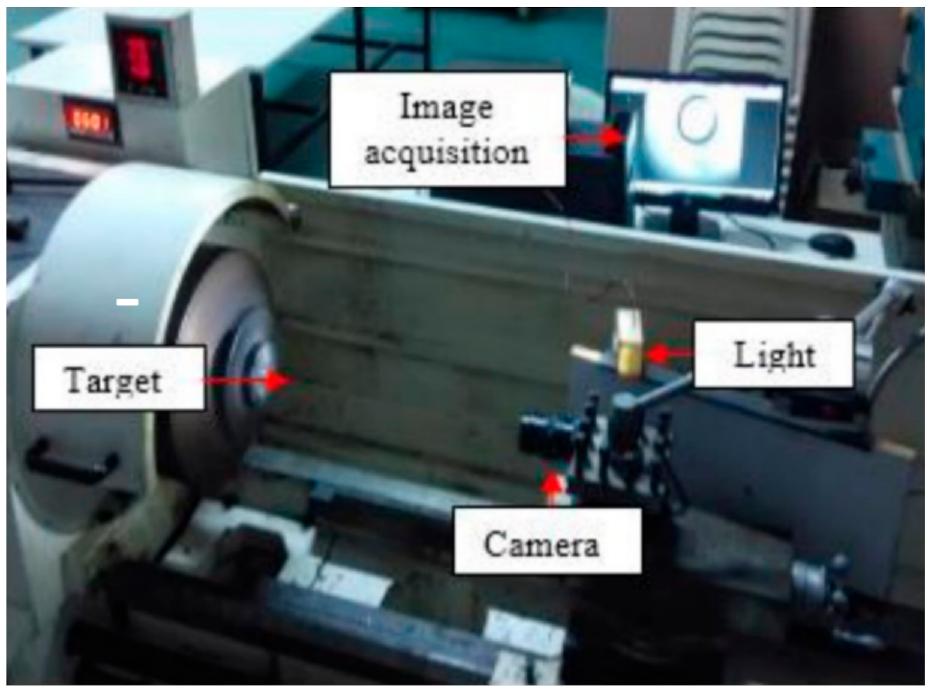
Figure 30. The experimental arrangement for spindle radial error measurement using the vision system in a lathe [32].